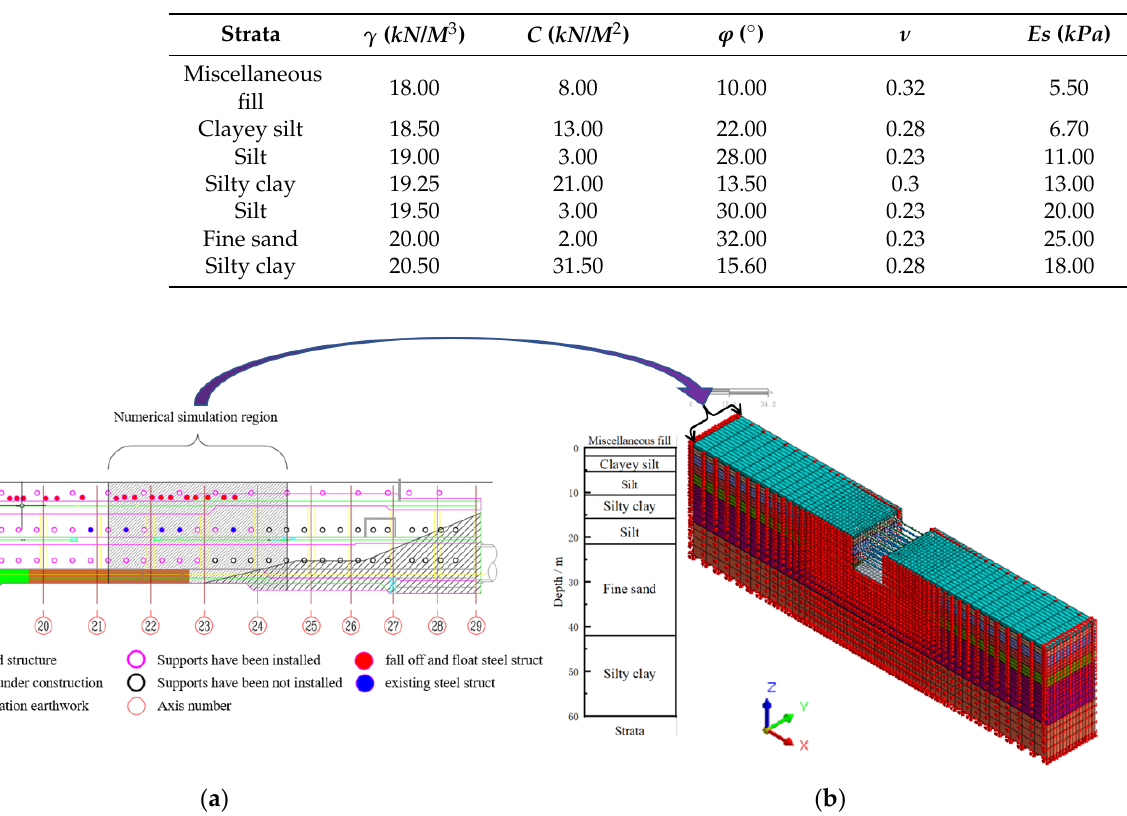
Table 2. Table of the physical and mechanical parameters of the soil.